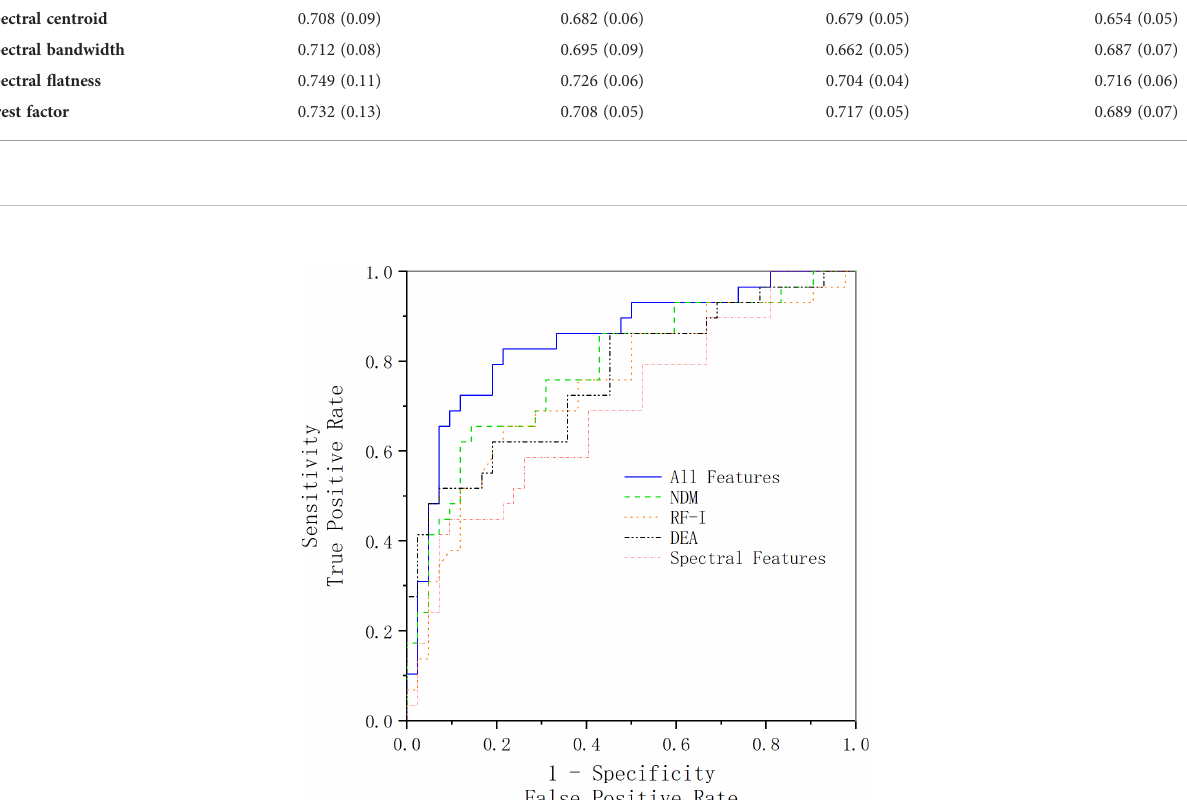
FIGURE 4 ROC curve acquired using the selected feature vector along with an SVM classi fi er. The blue line represents the ROC curve acquired using all features we have extracted and selected, the green line represents the ROC curve acquired using the features extracted from the NDM feature map, the black line represents the ROC curve acquired using the features extracted from the DEA feature map, the orange line represents the ROC curve acquired using the features extracted from the RF-I feature map, and the red line represents the ROC curve acquired using the spectral